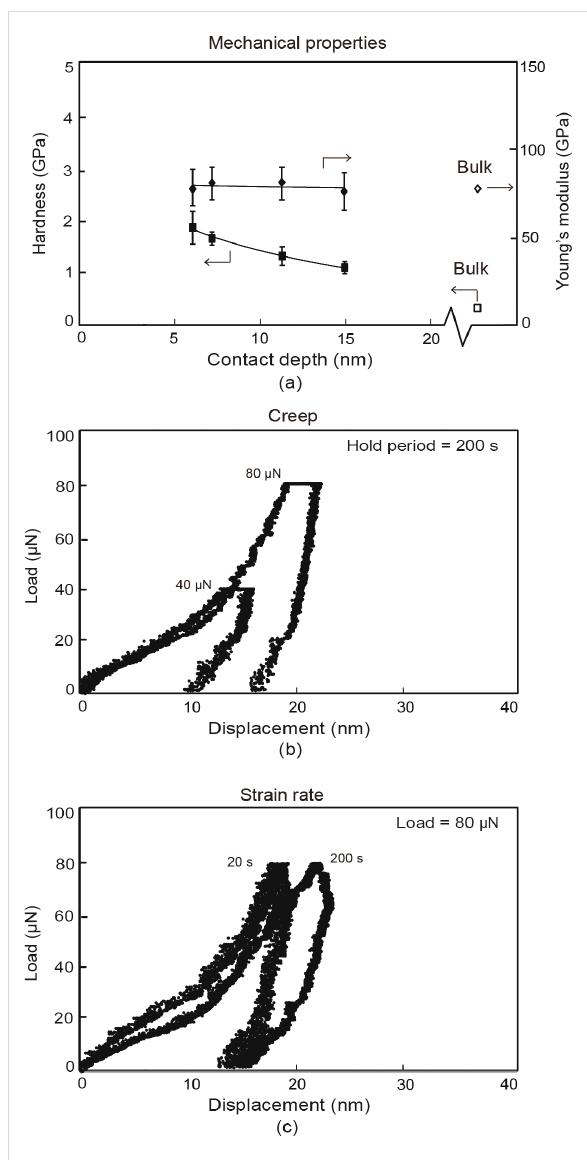
Figure 7: (a) Mechanical properties of thin films with hardness and Young’s modulus as a function of contact depth represented by bold square and diamond datum points, respectively, with corresponding open diamond and square datum points representing bulk mechanical properties. Typical load displacement curves showing (b) creep at maximum loads of 40 and 80 µN with a hold period of 200 s, and (c) effects of varying strain rate at a maximum load of 80 µN for loading–unloading periods of 20 and 200